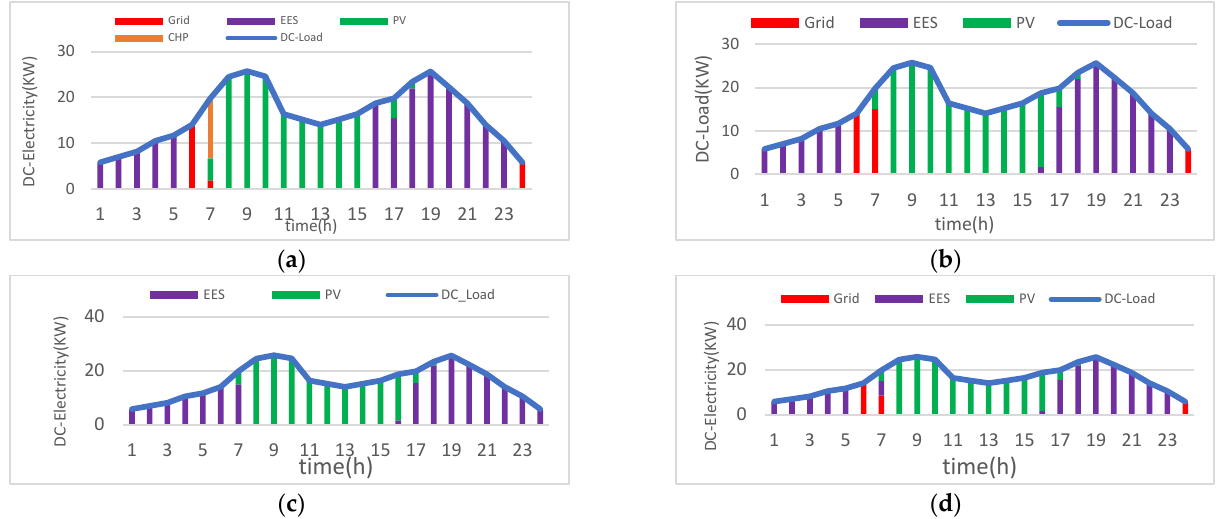
Figure 7. Optimal hourly DC-electrical demand balance ( a ) scenario 1 ( b ) scenario 2 ( c ) scenario 3 ( d ) scenario